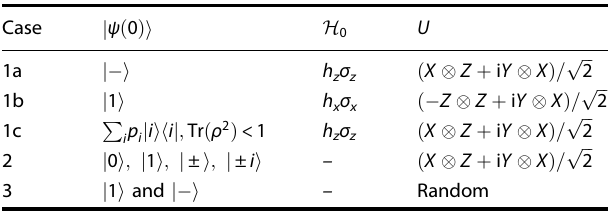
Table 1. Table of different experimental